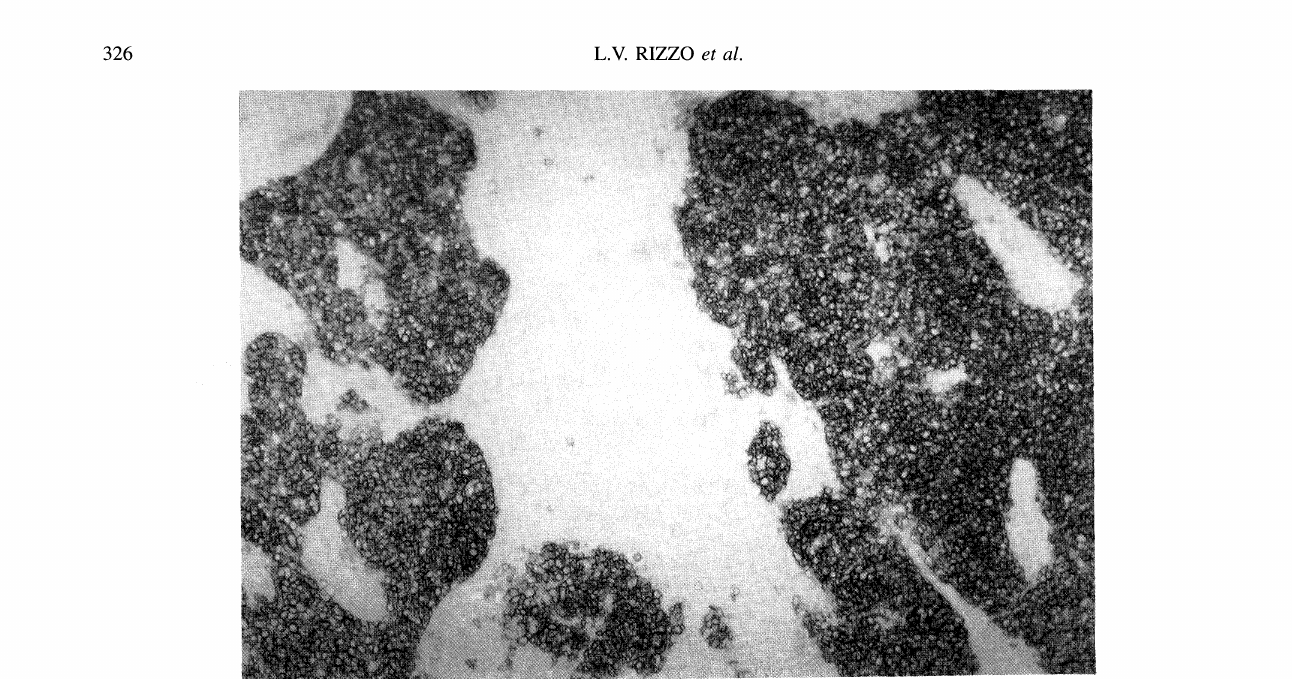
FIGURE Abnormal germinal centers in Peyer’s patch of middle-aged SJL mouse. Note the irregularly shaped areas of PNA large blast cells in the lower part of the mucosa of this Peyer’s patch. Staining was with peoxidase-labeled PNA and methyl green. Magnification: